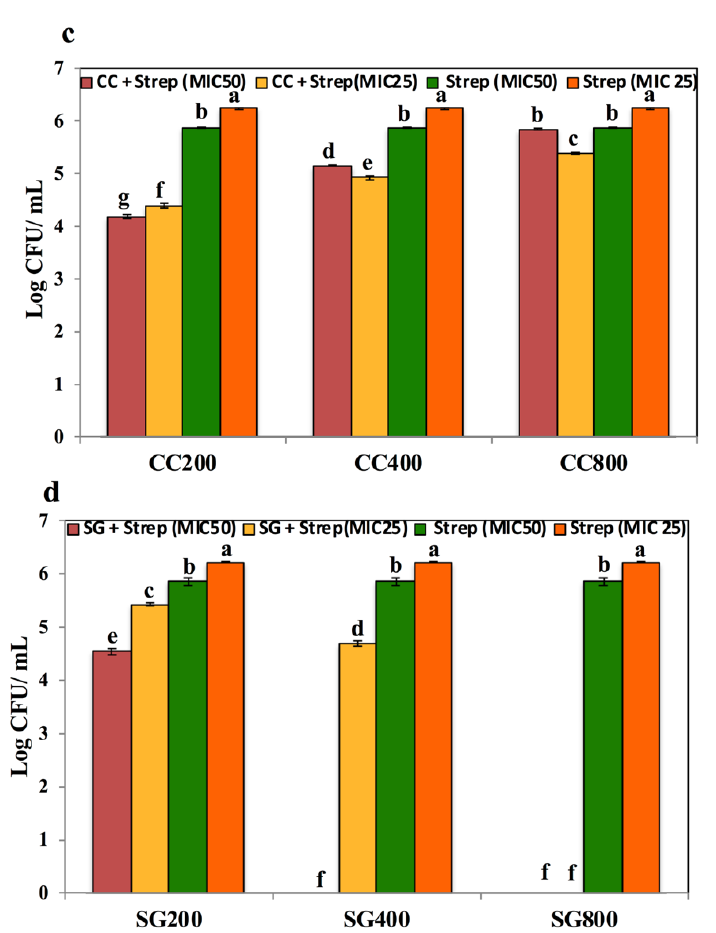
Figure 1. Combined e ff ects of antibiotics and seaweed extracts (SWE) on S . Enteritidis. Tetracycline (Tetr) and streptomycin (Strep) at MIC 50 and MIC 25 were tested in combination with seaweeds Chondrus crispus (CC) and Sarcodiotheca gaudichaudii (SG) at three di ff erent concentrations (200, 400 and 800 µ g / mL) ( a ) CC and Tetr; ( b ) SG and Tetr; ( c ) CC and streptomycin (Strep); ( d ) SG and Strep. Values with di ff erent superscript letters were significantly di ff erent ( p < 0.05). Values represented mean ± standard deviation from three independent experiments ( n = 9).